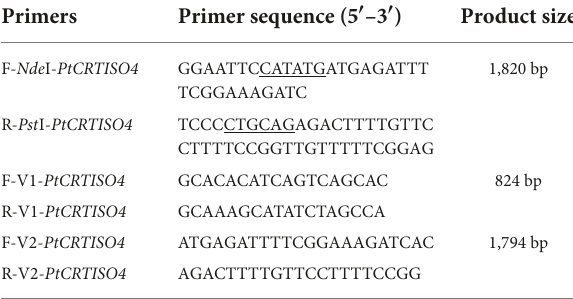
TABLE 1 Primers for PtCRTISO4 isolation and positive transformants